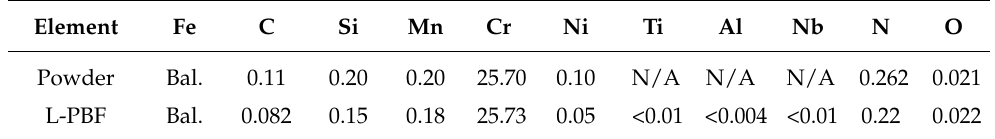
Table 1. Chemical composition of the powder and L-PBF-produced SS446 ferritic stainless steel in wt.%.